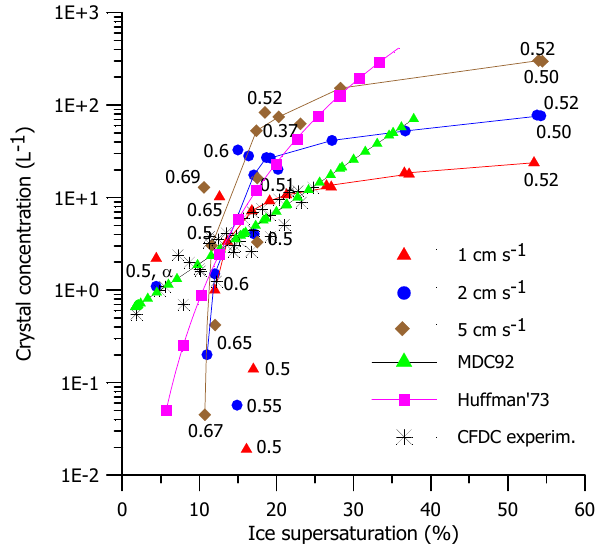
Fig. 6. The ice supersaturation dependence of the crystal concentration N c ( s i ) calculated with KC04-KC05 scheme. Each solid circle on the curves corresponds to a final N c after a single run of the parcel model with α = 0. The data are mostly the same as in Fig. 4 but plotted here as a function of ice supersaturation. The red, blue and brown symbols and lines denote simulations with vertical velocity w= 1, 2 and 5 cm s -1 . The contact parameter m is = 0.52 along the lines (as shown at the right ends) and is indicated near the points where it is different from 0.52; the symbol “ α ” denotes the runs with active site parameter α =2 × 10 -5 , which yields N c = 1-3 L -1 at s i ≈ 5 %. With this or similar value α , all points would be shifted to lower supersaturations by ~ 5-7 % and would be closer to MDC92 curve and experimental points at lower ice supersaturations. The parameterization curve from Meyers et al. (MDC92, extended to s i = 38 %) is denoted with green color and triangles. Huffman’s (1973) parameterization with C b iiHic sCsN = )( iH = 10 -5 L -1 (chosen here to match the lab data) and b = 4.9 is shown in magenta. Black crosses denote experimental points from CFD chamber by Rogers (1982, 1988) and Al-Naimi and Saunders (1985) (courtesy by Paul DeMott).